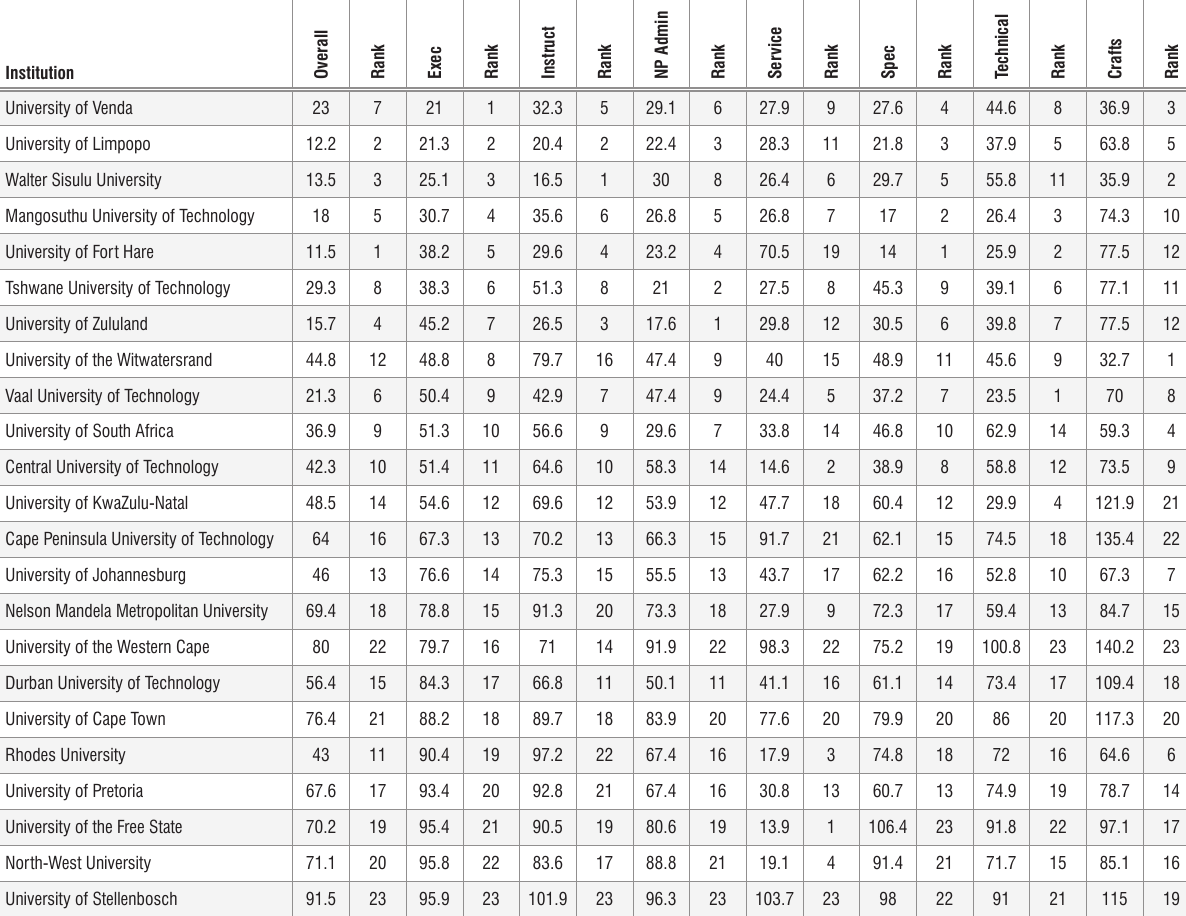
Table 5: Equity Indices for staff categories at universities in South Africa together with institutional rankings within each category